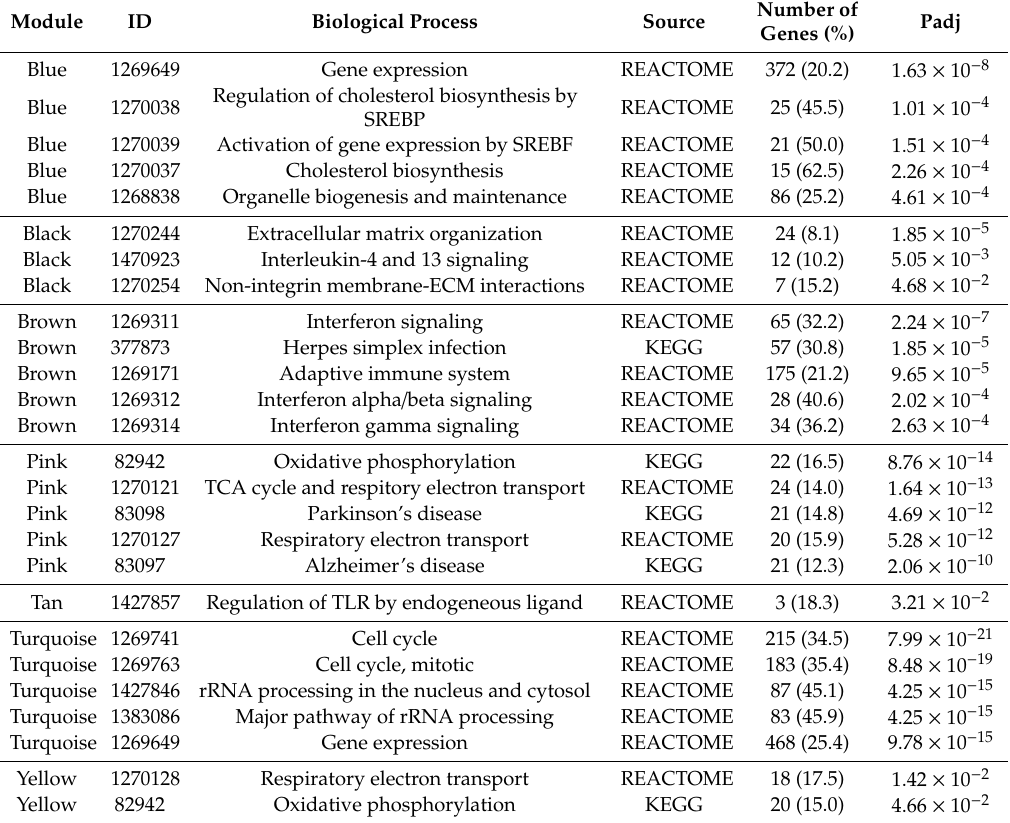
Table 2. Significantly enriched pathways (KEGG / REACTOME) for each module of the WGCNA. Modules not mentioned have no significant enriched term based on the Bonferroni-adjusted p -value.